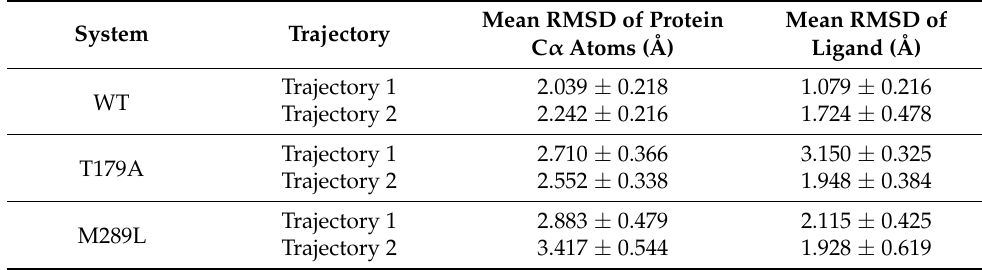
Figure 2. The root mean squared deviation (RMSD) of Protein C α and ligand averaged over the two runs in ( A ) WT, ( B ) T179A, S282T, and ( C ) M289L systems. Table 1. The mean RMSD of Protein C α atoms and Mean RMSD of ligand calculated for each